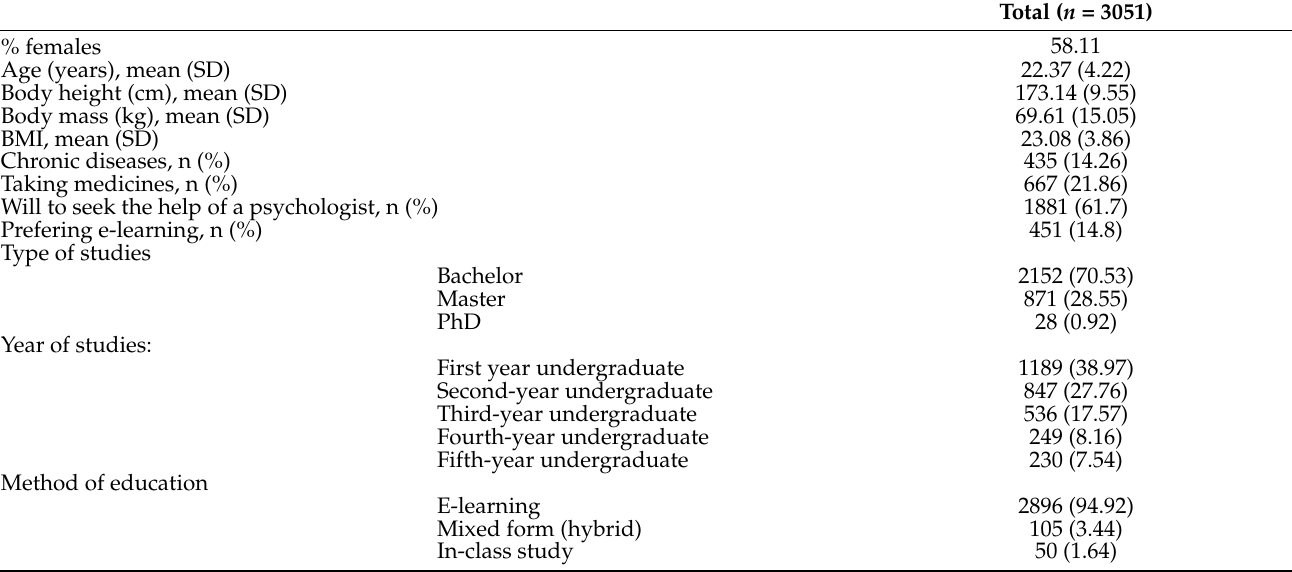
Table 2. Participant’s